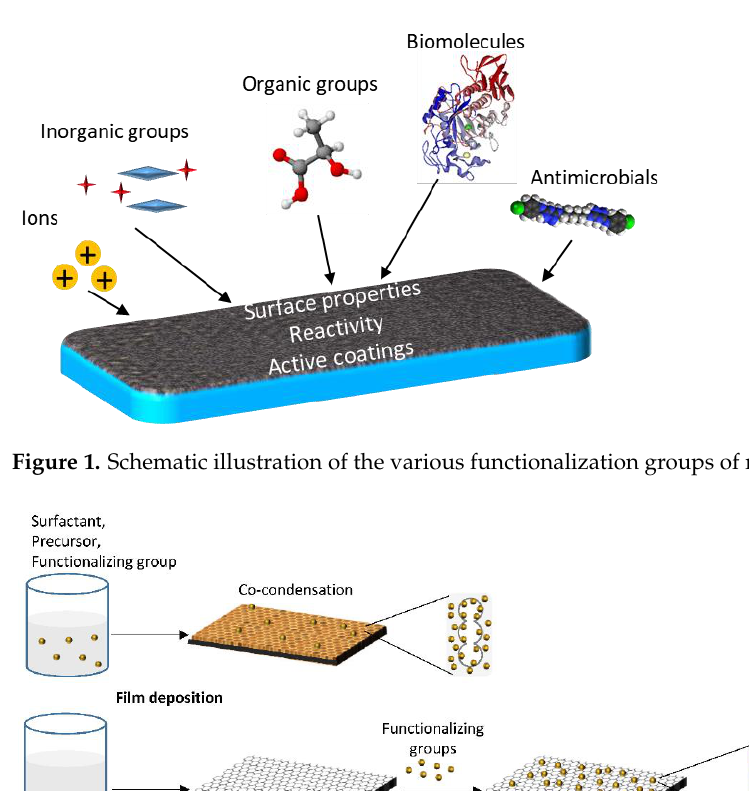
Figure 2. Schematic representation of mesoporous thin film functionalization. Post grafting ( bottom ) promotes the accessibility of more functional groups, with respect to co-condensation ( top ) where they are dispersed through the whole mesoporous matrix instead of the pores surface only.